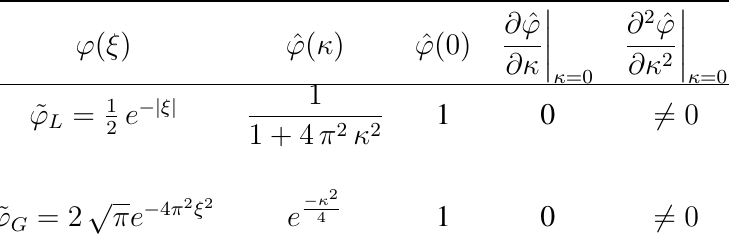
Table 2. Fourier transforms of two weight functions.